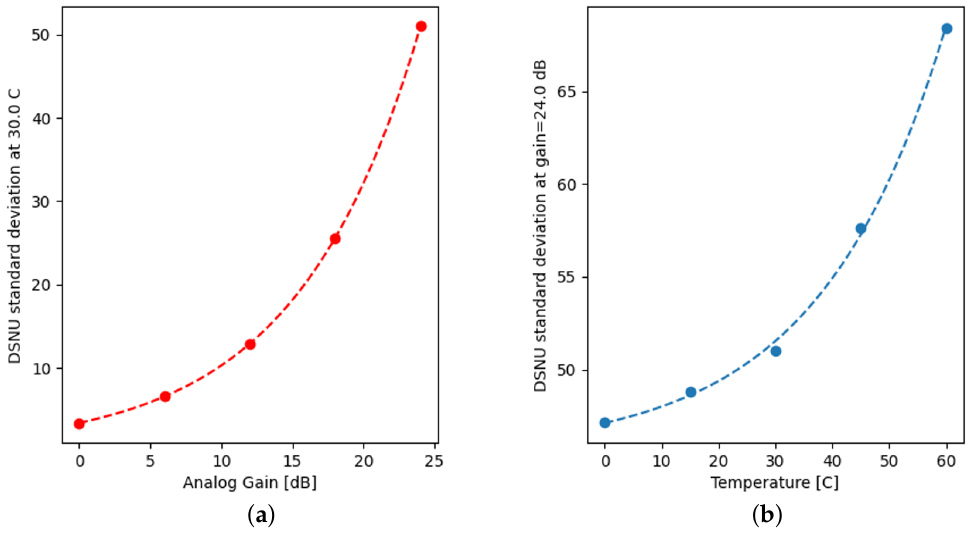
Figure 11. Standard deviation of DSNU at 30 ◦ C ( a ) and at a gain of 24.0 dB ( b